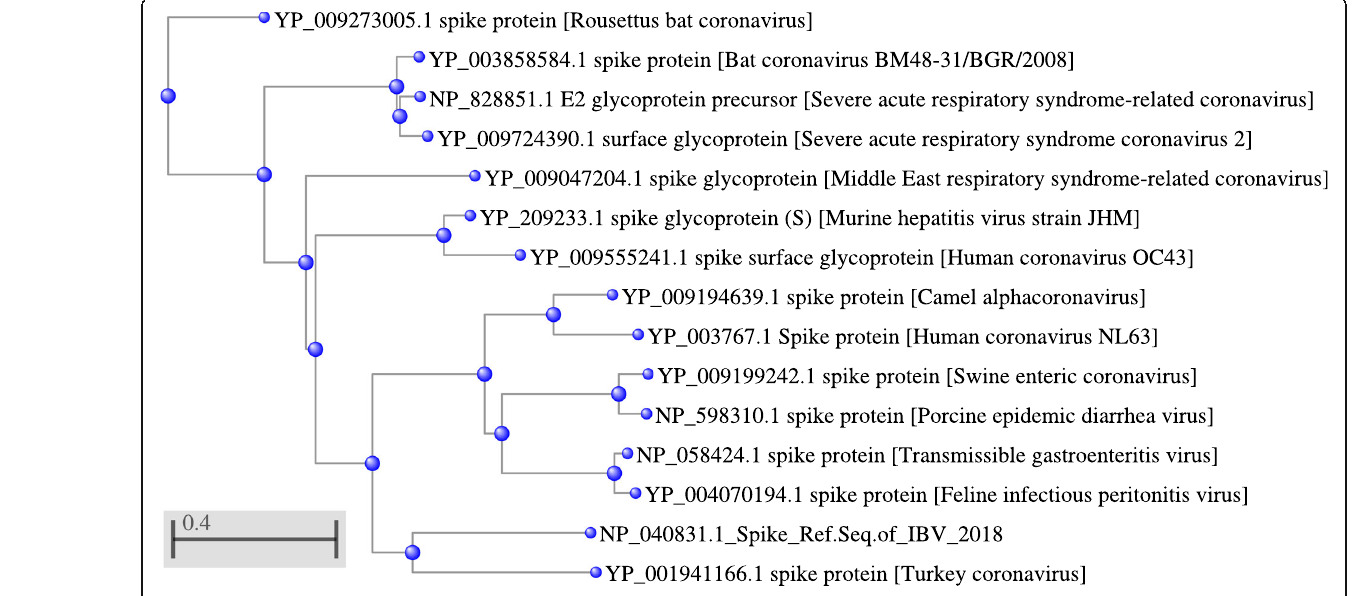
Fig. 2 Phylogenetic tree of IBV against other coronaviruses in human and